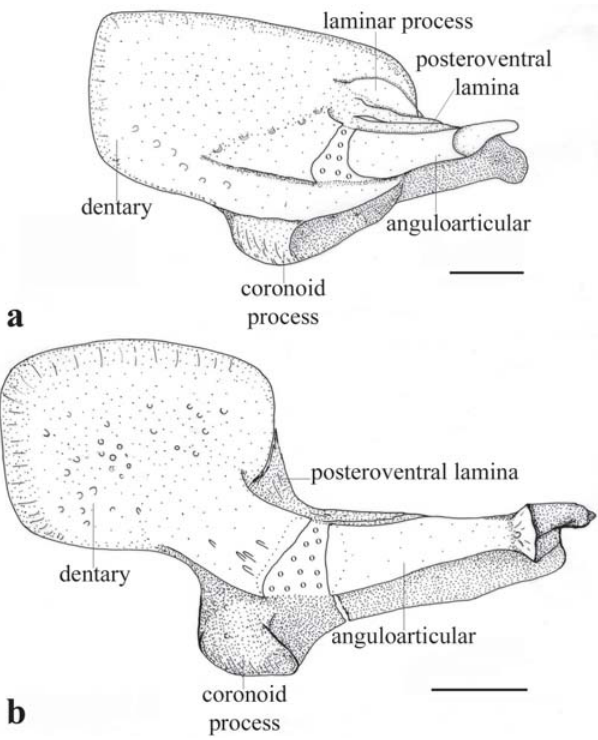
Fig. 31. Dorsal view of dentary and anguloarticular (left side) of Harttia loricariformis (MZUSP 66187, 67.7 mm SL) (a), and Lamontichthys filamentosus (LACM 41741-9, 119.4 mm SL) (b). Scale bar = 1